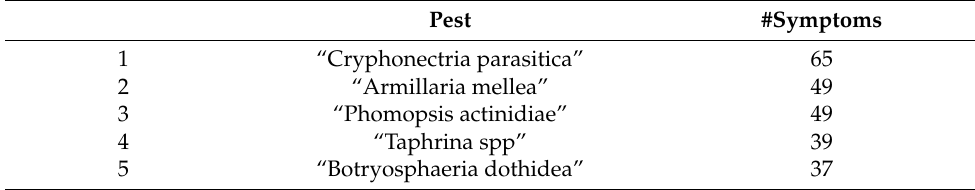
Table 2. Pests and number of associated